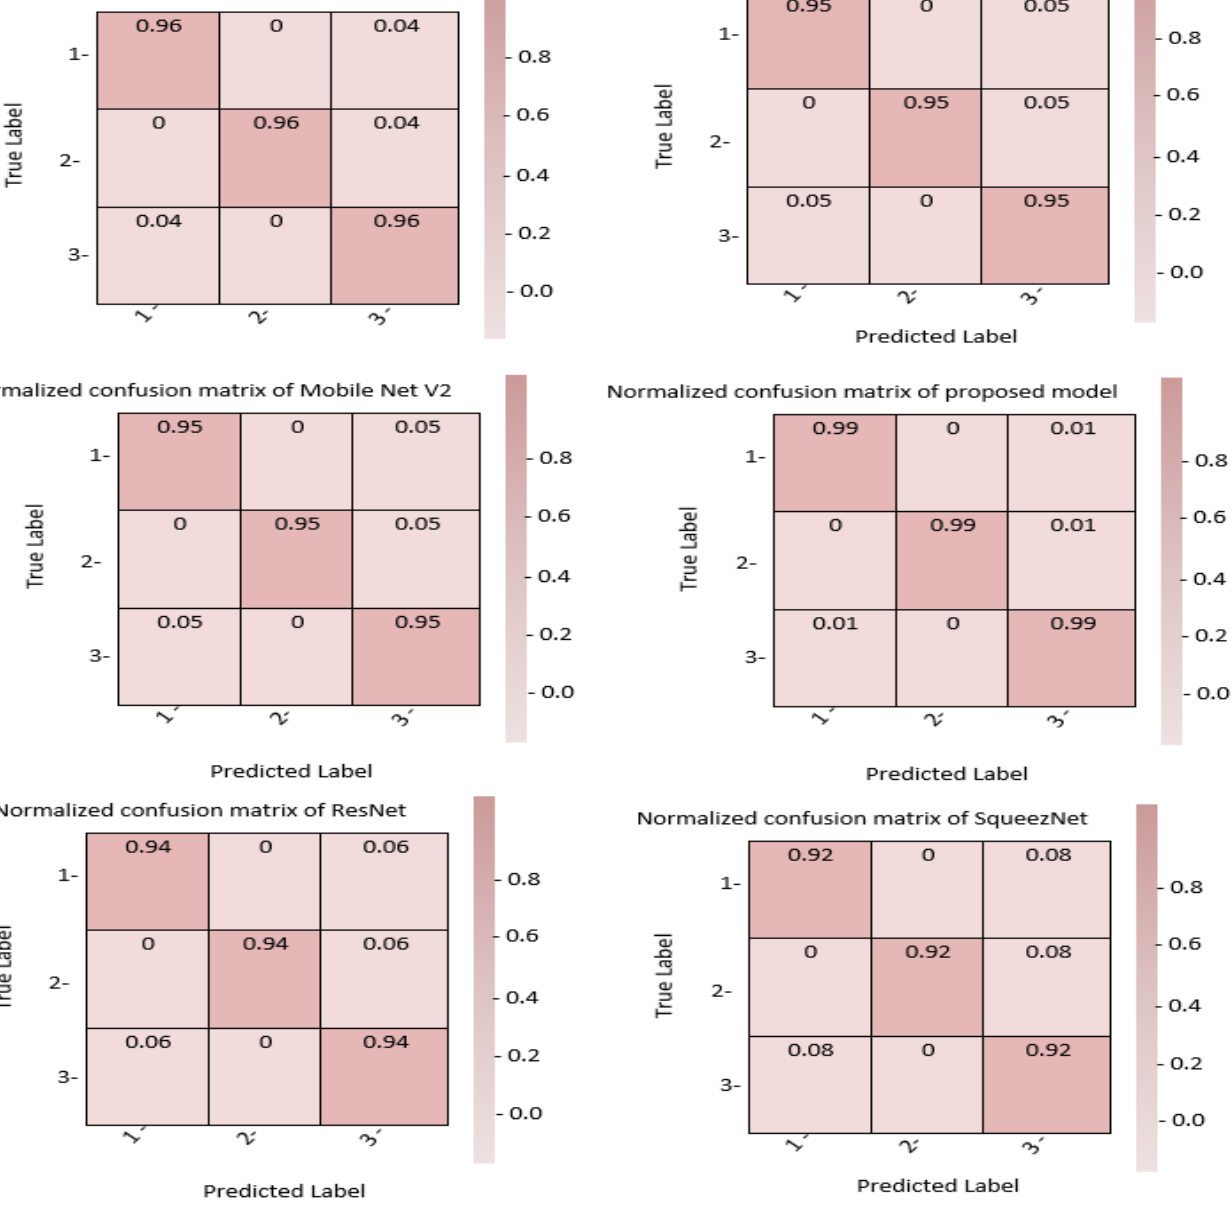
Figure 7. Presents the confusion matrix of the proposed transfer learning techniques in brain tumor